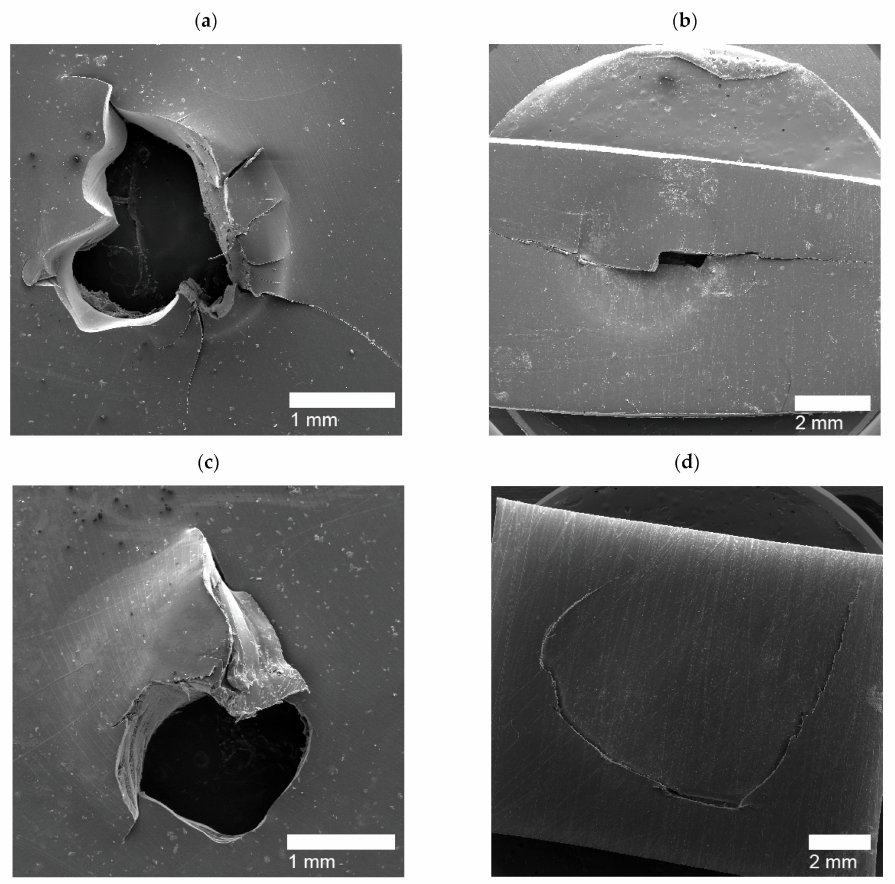
Figure 13. ( a ) Brittle hole from a PEMAA-71%Zn-M190 sample ( b ) Line fracture from a PEMAA-